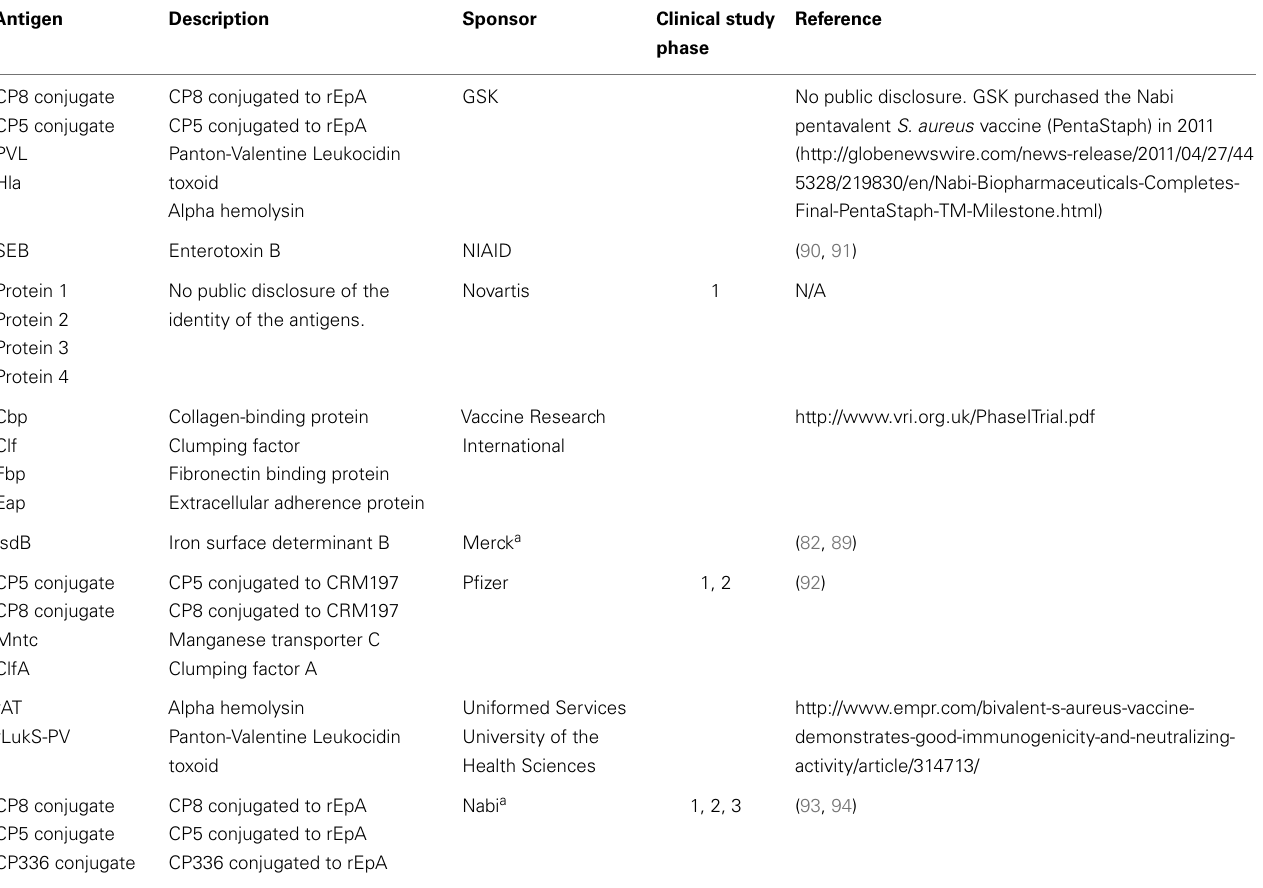
Table 2 |Vaccine antigens targeting S. aureus that have been evaluated in human clinical trials